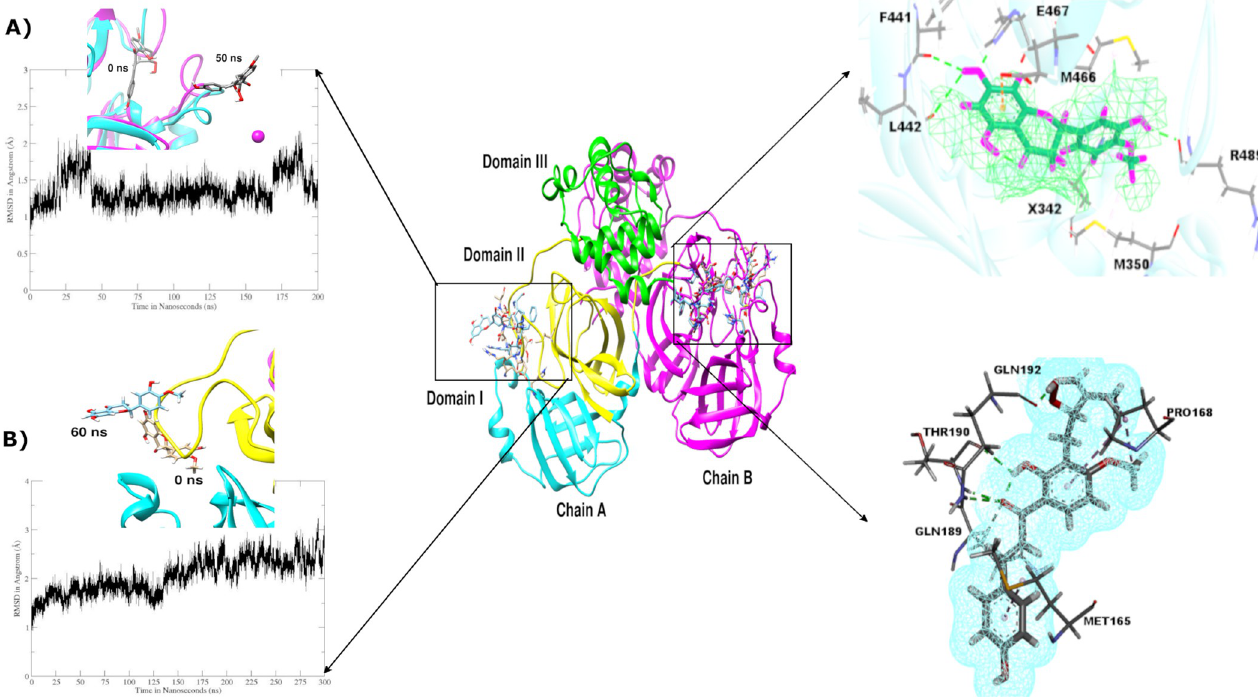
Fig 7. a) Hesperetin detached itself from chain A due to structural dynamics in its cavity but stayed intact with chain B till 200 ns as displayed in the top-right image. b) Xanthoangelol_E exhibited the same behavior with the chain while displaying strong hydrogen bond interactions and ligand movement deeper in the cavity of chain B till 300 ns, as presented in the bottom-right corner